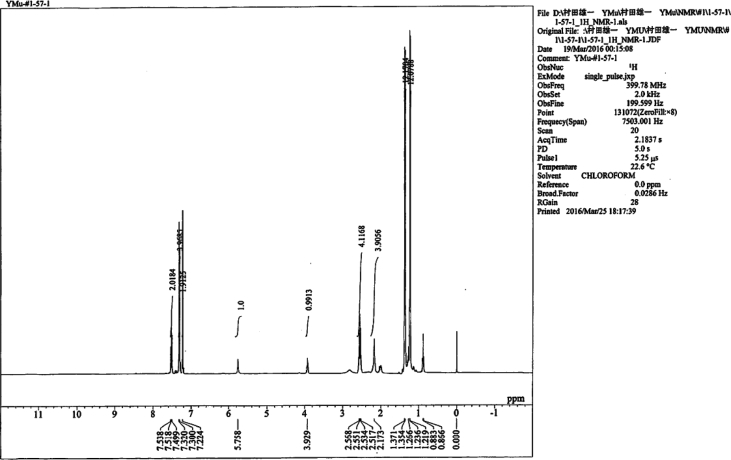
1H NMR spectrum of [Au(RS-pyrrld)(IPr)] (1) in CDCl3 at 22.6 °C.